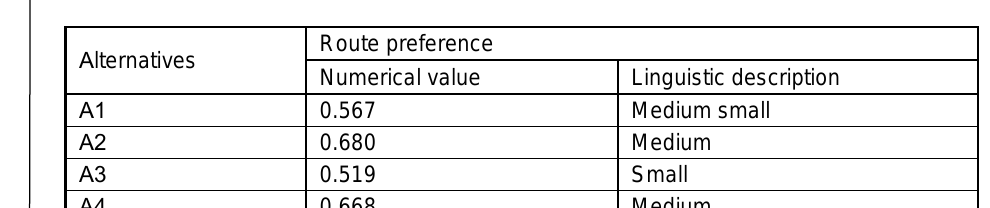
Table 5 – Evaluation of the